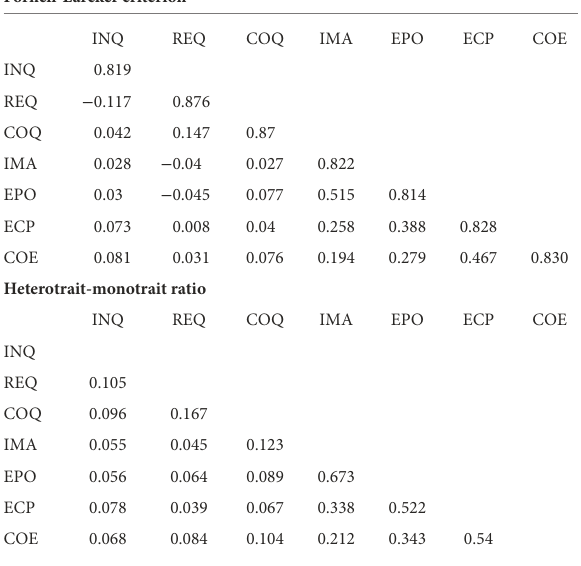
TABLE 2 Discriminant